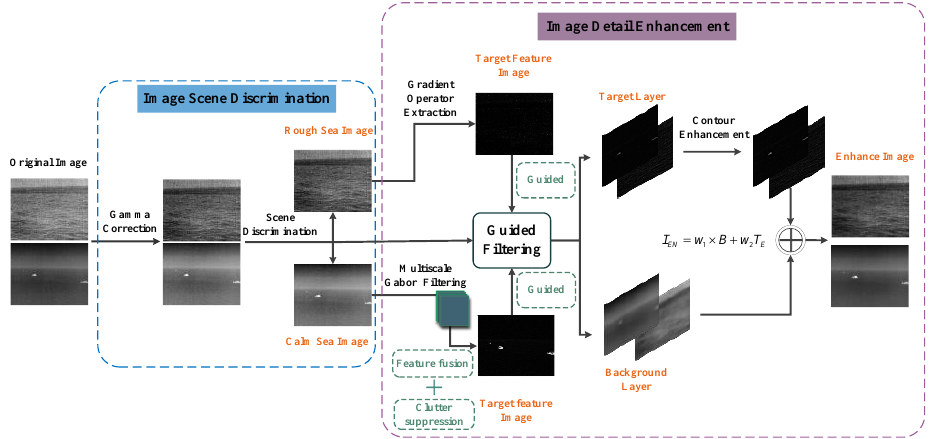
Figure 6. Flowchart of the proposed method.